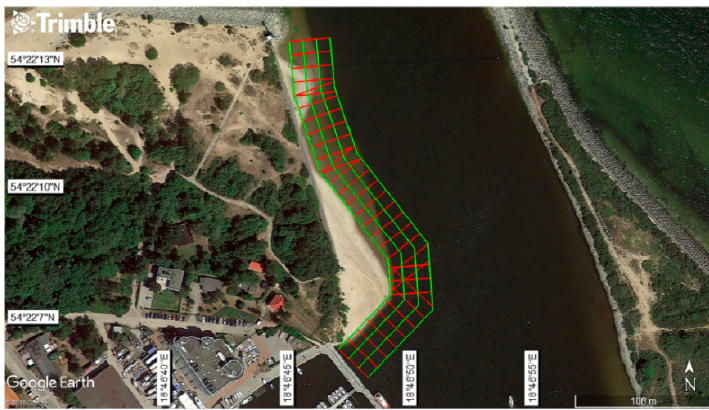
Figure 3. The system of main and control profiles in the territorial sea baseline determination for waterbody No. 2.